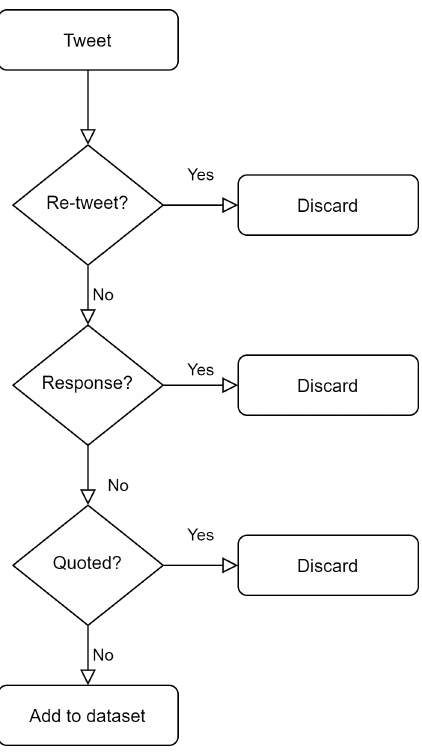
Figure 2. Tweet collection